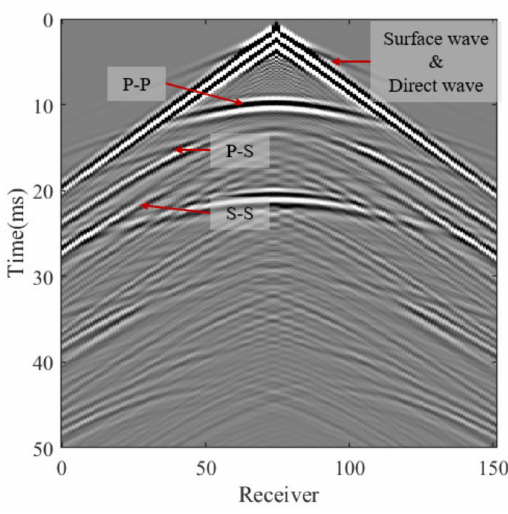
Figure 19. Components in a seismic